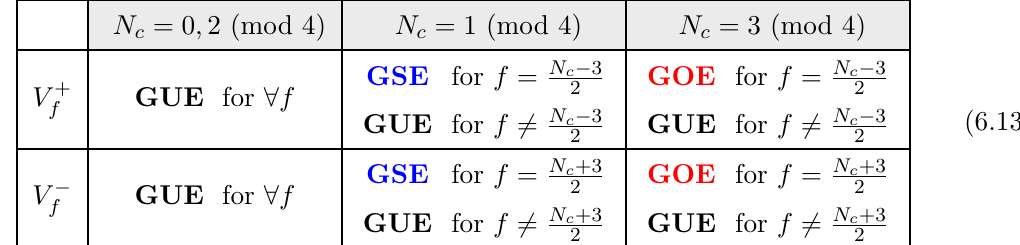
Figure 10 . Distribution of the ratio r of two consecutive level spacings for the N = 2 SYK model with ^ q = 3. The label n = f (cid:6) ( f = 6 ; 7) refers to levels of H on V (cid:6) . The number of realizations f used for averaging is 10 3 for N c = 15 and 10 2 for N c = 16 and 17. The blue lines are surmises for the RMT classes of (6.13). The twofold degeneracy for the GSE case was resolved before the statistical analysis. In the right-most plot of N c = 16 we show the result obtained by an incorrect analysis, when levels from V + and V (cid:0) are mixed into a single sequence. Although the result is f f surprisingly well (cid:12)tted by the GOE, this is misleading: there is no antiunitary symmetry in this sector. This highlights the danger of inferring the symmetry class from spectra on the full V f